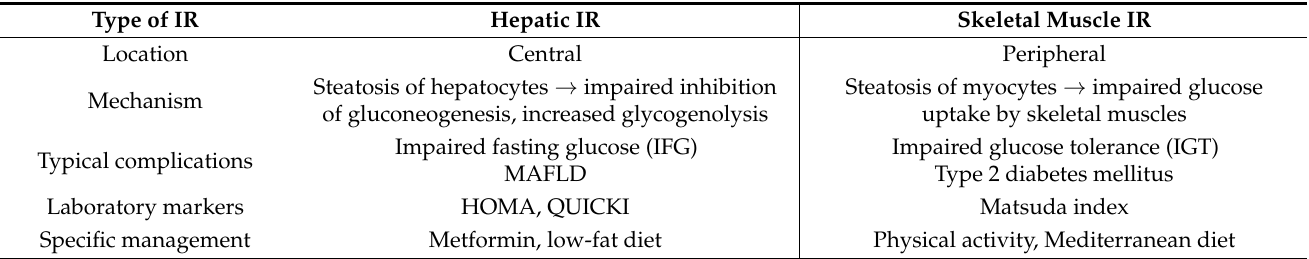
Table 3. Comparison of the two main IR